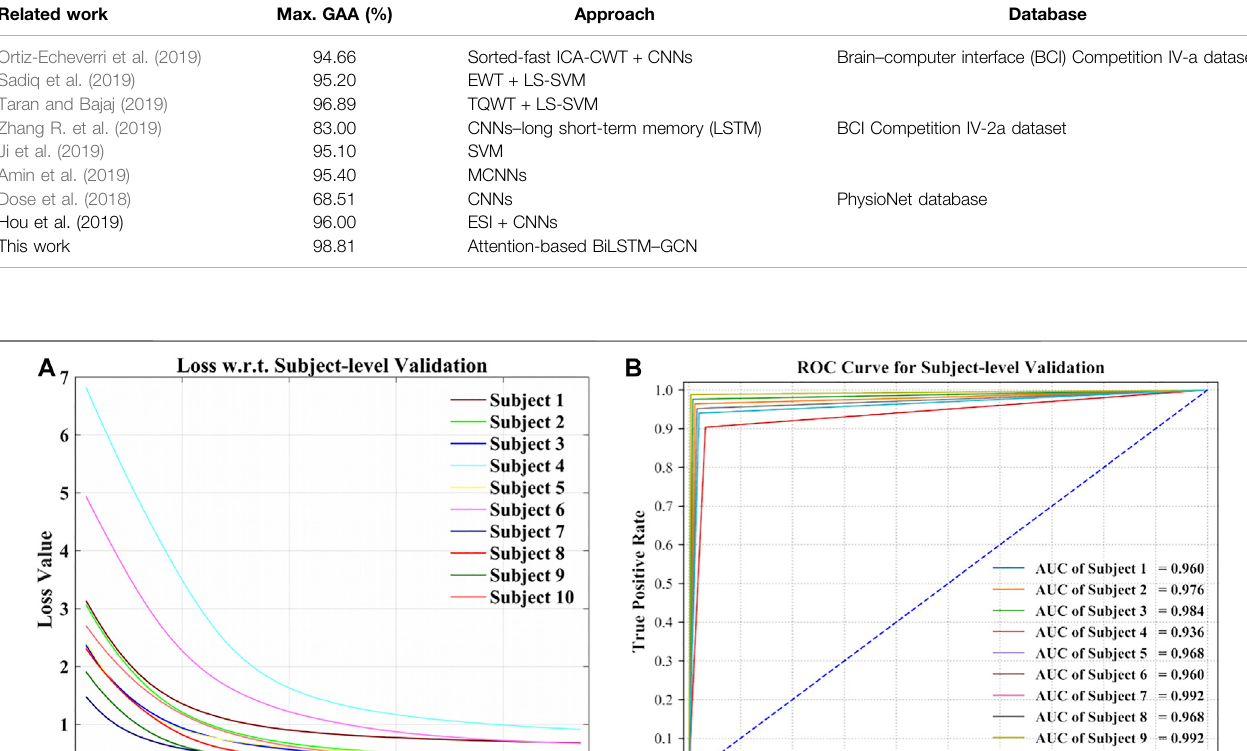
TABLE 3 | Comparison of current studies on subject-level prediction. Related work